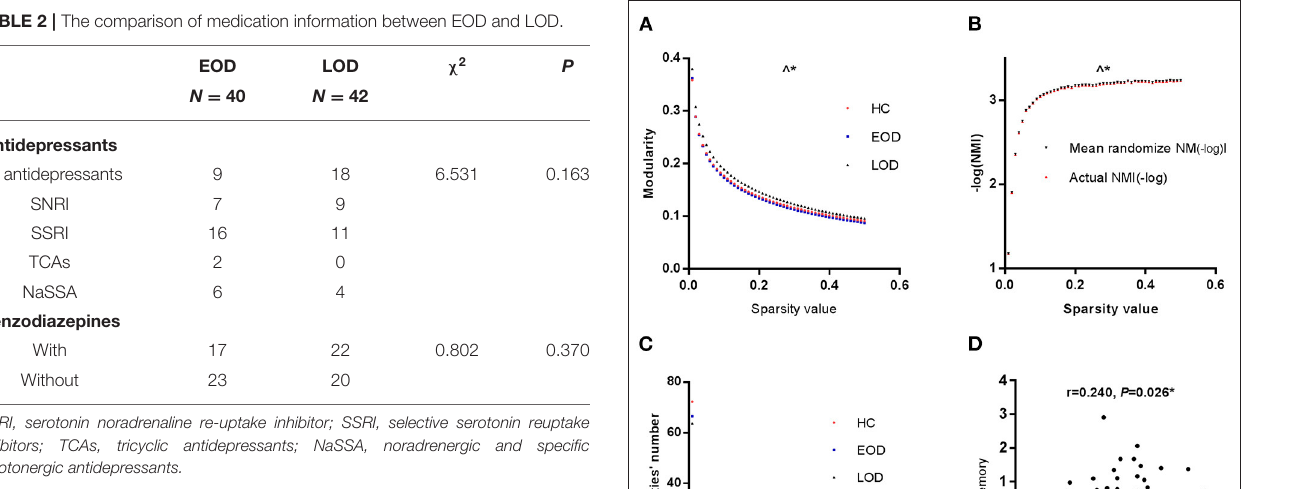
regression after adjustment for age, year of education, gender and HDRS, modularity acted as an influence factor on memory (beta = 0.217; P = 0.026) in the HC